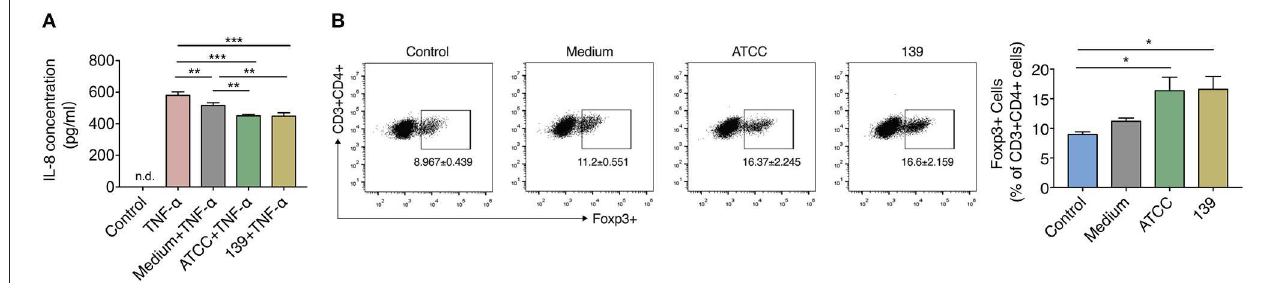
FIGURE 2 | BCS from A. muciniphila ATCC and 139 exert anti-inflammatory but no immune-modulatory properties in vitro . (A) IL-8 concentration produced by HT-29 cells. Control, negative control without TNF- α stimulation; n.d., non-detectable. (B) Foxp3 + Tregs in the CD4 + T cells (CD3 + CD4 + ) detected by flow cytometry. Cytokines hTGF- β and rmIL-2 were added to facilitate the expression of Foxp3 + Treg cells. Data are the frequency of the Foxp3 + Treg cells among the CD3 + CD4 + cell population. Control, cells without cytokines. All the data are shown are means ± s.e.m., n = 3 for all groups. Values of each group were calculated by one-way analysis of variance (ANOVA) followed by Tukey’s post-hoc test. * P < 0.05, ** P < 0.01, *** P <